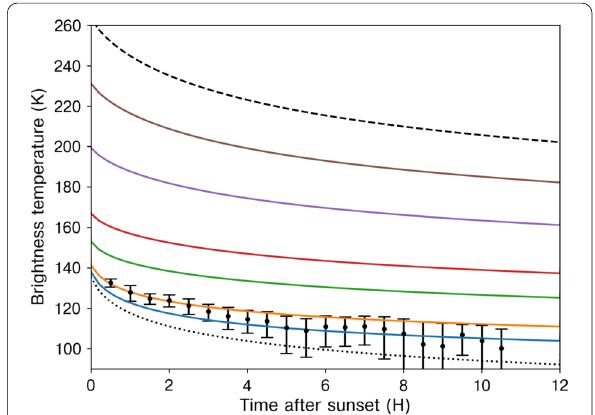
Fig. 9 Average equatorial brightness temperatures at band 14 in the nightside. Black points with error bars are the average values with standard deviations at every 0.5 H bin. The black dashed and dotted lines show surface temperature models of lunar rock and regolith at the equator, respectively. The blue, orange, green, red, purple, and brown solid lines are brightness temperature curves of mixture models with rock ratios of 0.2, 0.5, 2, 5, 20, and 50%